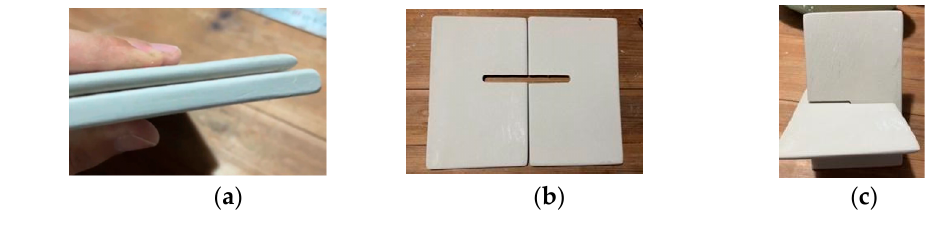
Figure 8. ( a – c ) Experimentation by trial and error.